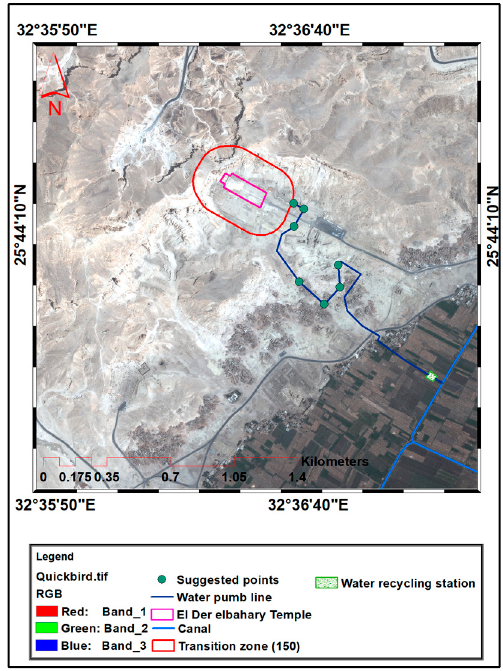
Figure 18. Proposed GIS-modeling around Hatshepsut temple by Quick bird satellite image 2005 (RGB).